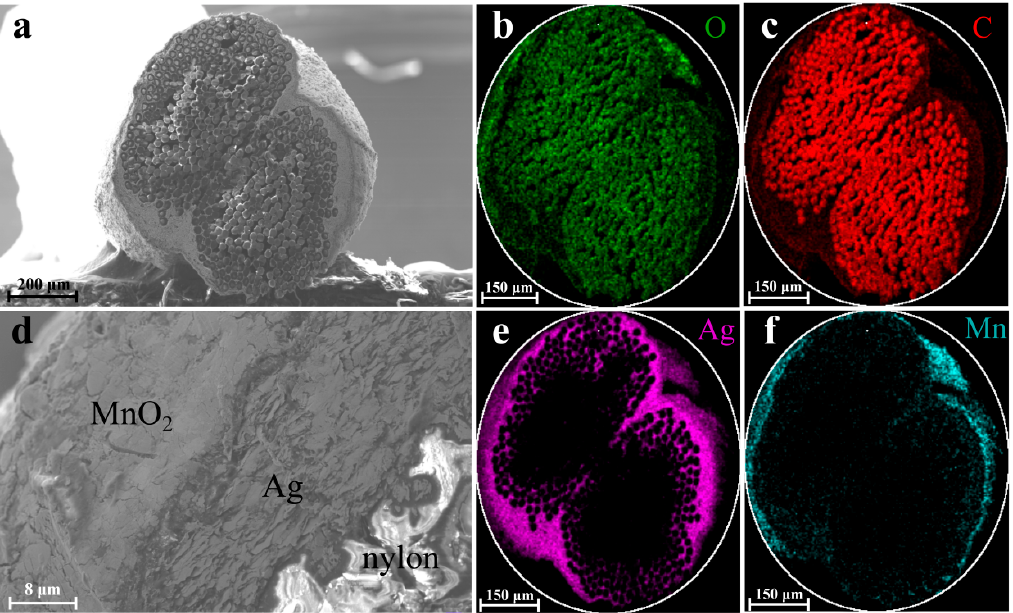
Figure 3. ( a ) Cross-sectional SEM images of the nylon/Ag/MnO 2 electrode; ( b ) oxygen and ( c ) carbon element distribution in the cross-section derived from EDS mapping scan results of the nylon/Ag/MnO 2 electrode; ( d ) different material layers of the cross-section of the nylon/Ag/MnO 2 electrode; ( e ) silver and ( f ) manganese element distribution in the cross-section.